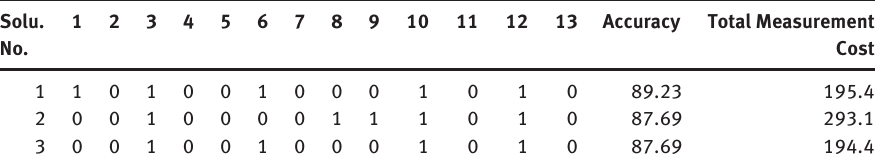
Table 12. Non-dominated Solutions in Case of the Heart Disease Data Set.